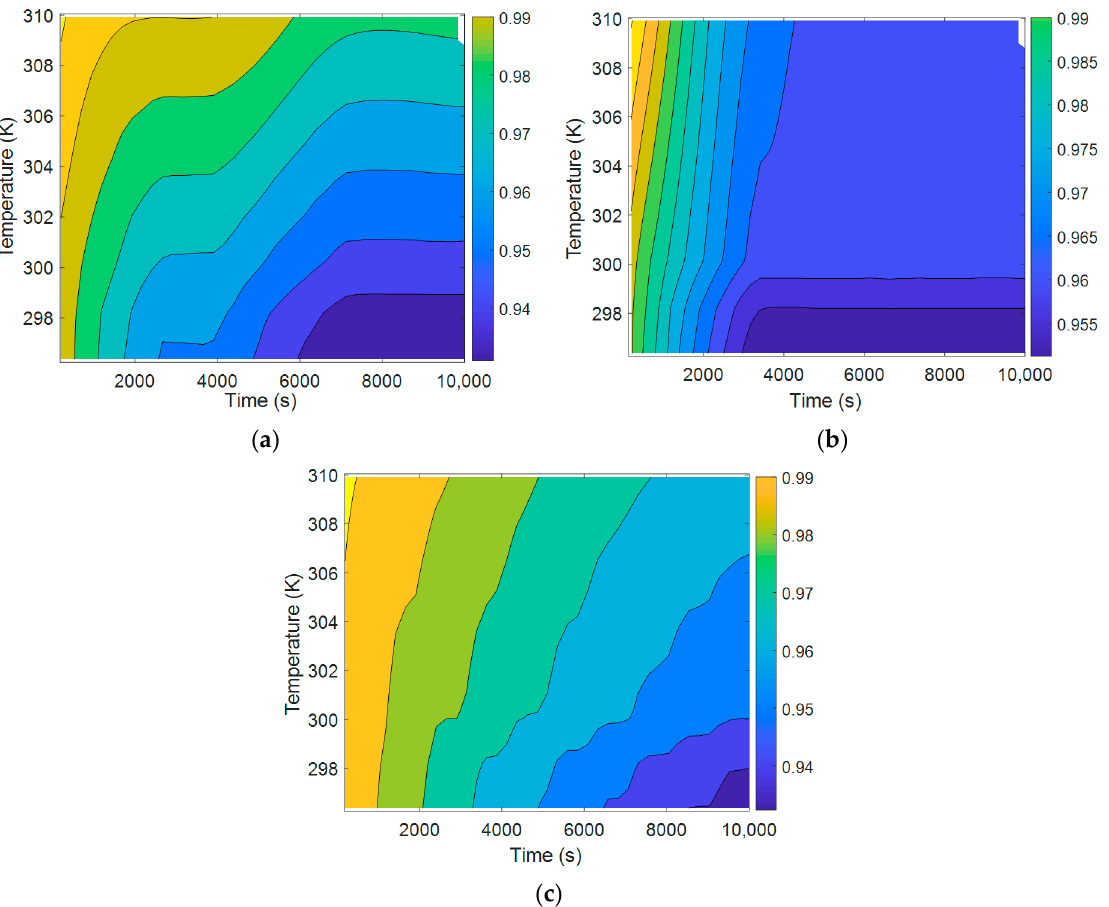
Figure 7. The impact of the changes in the operating temperature of the batteries on the output SOC: ( a ) case 1, ( b ) case 2, and ( c ) case 3.